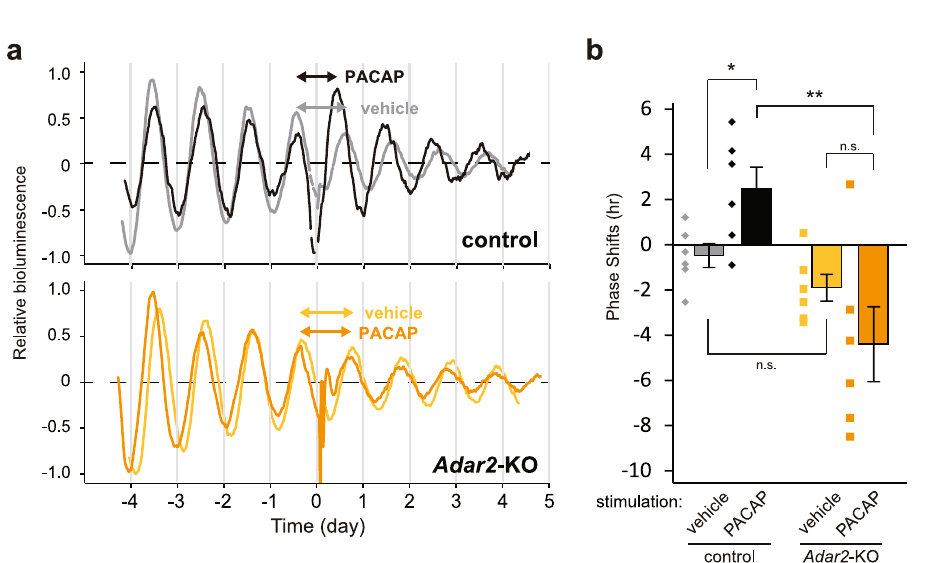
Figure 4. PACAP-induced phase-shift of bioluminescence rhythm recorded from the SCN slice in culture. ( a ) A representative set of bioluminescence rhythms of control (top) and Adar2 -knockout (bottom) mouse SCN. The time of the PACAP application (1 μ M, 1 h) was set to 0. The double-headed arrows indicate the peak intervals of the bioluminescence rhythms. ( b ) The phase-shifts induced by the PACAP application (mean ± SEM; n = 6; n.s. P ≥ 0.05, * P < 0.05, ** P < 0.01 by Student’s t